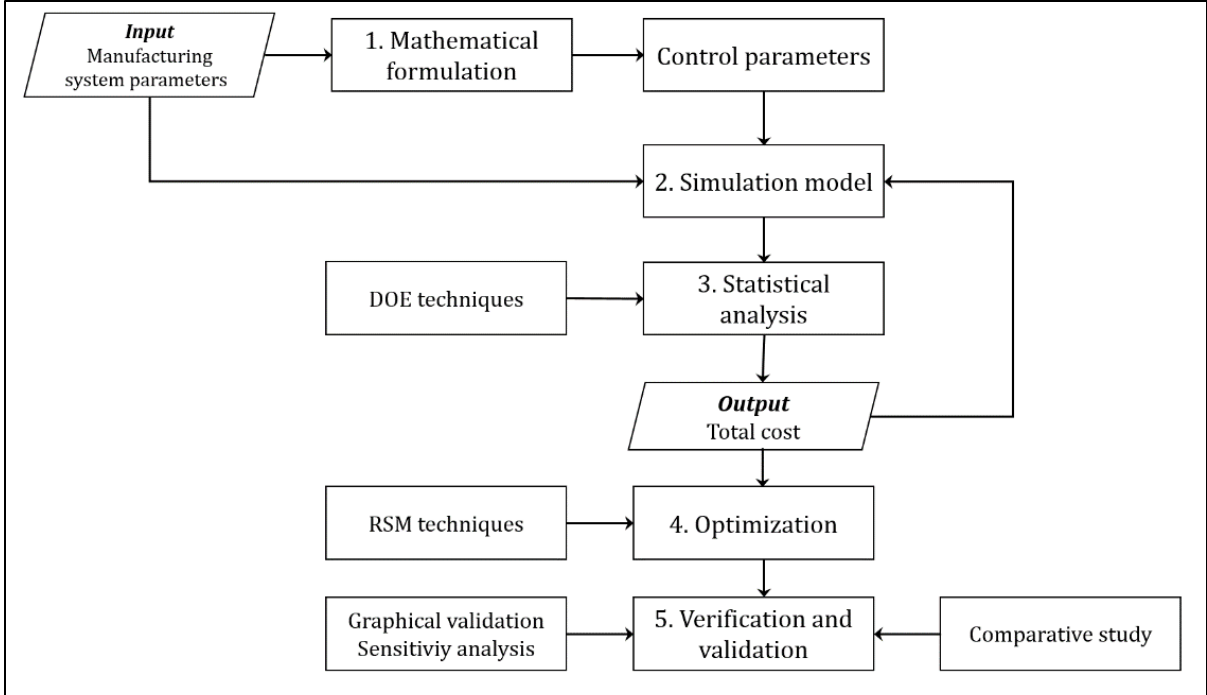
Figure 2. Resolution approach.